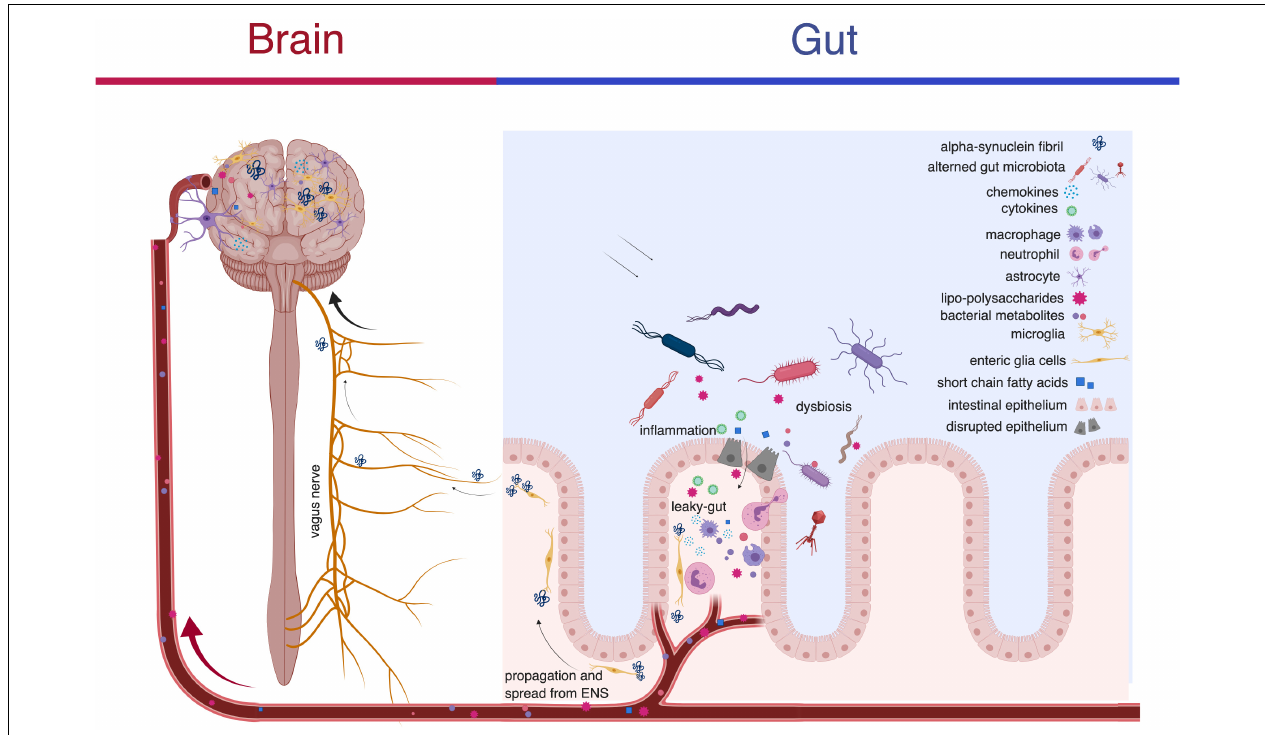
FIGURE 1 | A schematic representation of the microbiota-gut-brain axis illustrating how alterations in the microenvironment of the gut contribute to changes in the CNS in PD. Changes in the microbiota may initiate a pathological process in the gut by (1) increasing the permeability of the blood-gut and blood-brain barriers thereby providing a route of transmission between the contents of the gut and the brain and (2) inducing formation of fibrillar alpha-synuclein pathogenic species. LPS and metabolites produced by the microbiota gain access to the CNS via the compromised barriers. The alpha-synuclein fibrils propagate to the brain via the vagus nerve where they induce other alpha-synuclein to undergo conformational change in a prion-like process. Alpha-synuclein and LPS also stimulate the release of pro-inflammatory factors such as: TNF-alpha, IL-lbeta, IL-2, IL-4, IL-6 from immune cells like macrophages, neutrophils and dendritic cells, increase expression of c-Jun, c-Fos, FosB, and cyclin B2 and promote production of chemokines like CCL2, CCL5, CCL17/TARC, CCL20, CXCL1, and CX3CL1 that are widely involved in neuroinflammation. These pro-inflammatory factors, chemokines and alpha-synuclein fibrils are powerful chemoattractants for microglia, neutrophils and astrocytes and may further impair normal ENS and CNS function. Created with